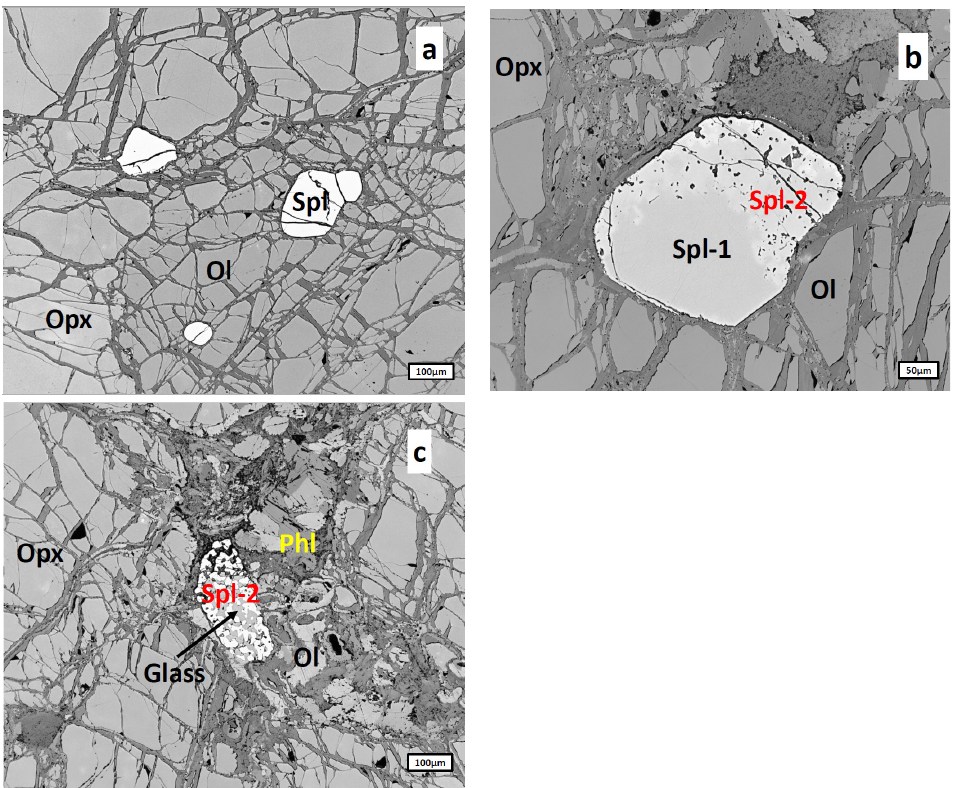
Figure 6. Types of spinels from harzburgites: ( a ), primary spinel (Spl) represented by clean homogeneous grains; ( b ), Primary spinel grains (Spl-1) surrounded by the spongy rim of resorption (Spl-2); ( c ), completely resorbed spinel grain (Spl-2) containing silicate glass material within the resorbed spinel matter. Ol, olivine; Opx, orthopyroxene; Phl, phlogopite.